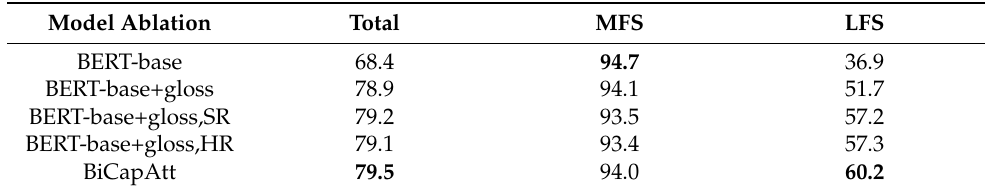
Table 5. Ablation study on the ALL